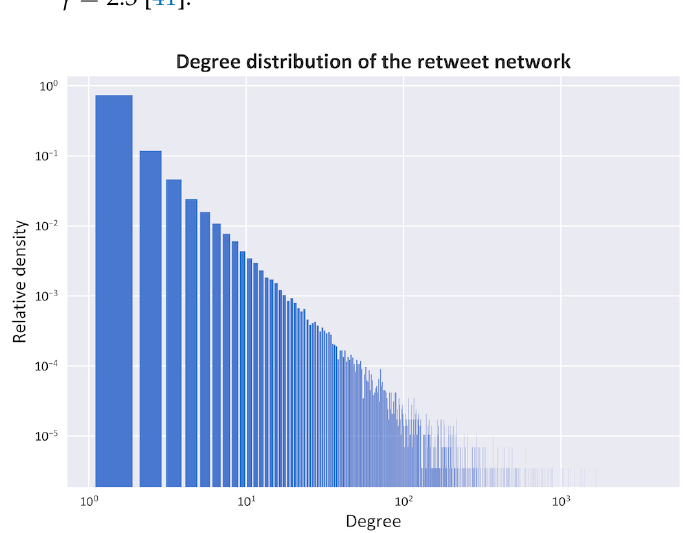
Figure 6. log–log long-tailed degree distribution of the retweet